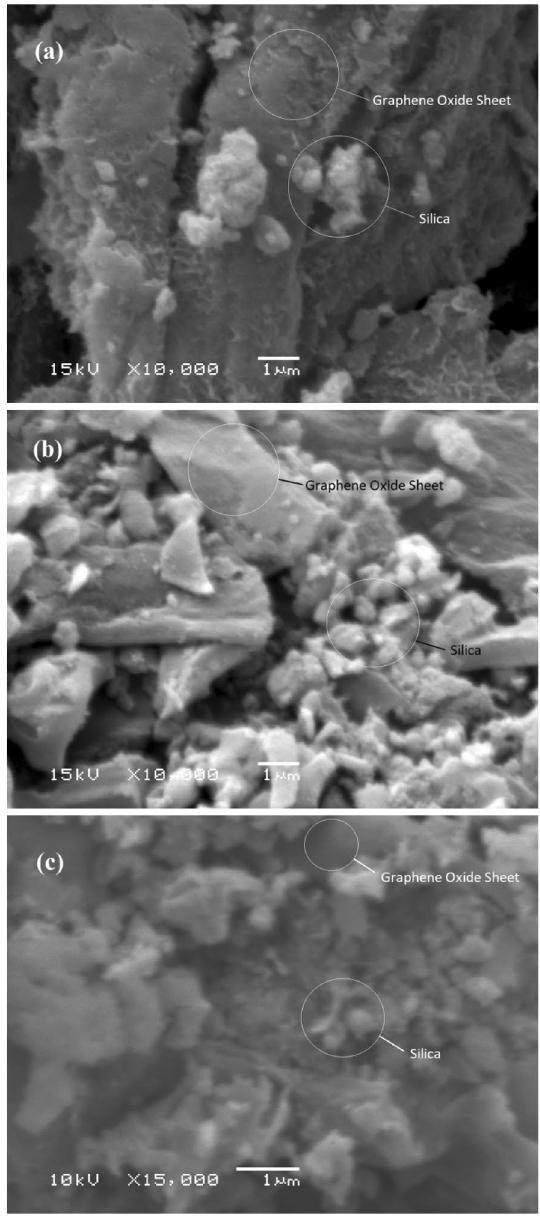
Figure 4. SEM images of prepared graphene oxide/SiO 2 nanocomposites: ( a ) FGS1, ( b ) FGS2 and ( c )